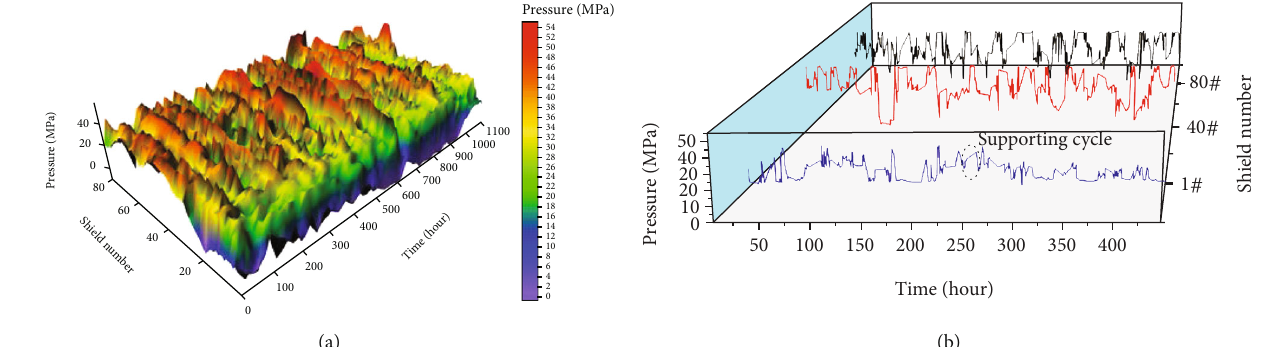
Figure 3: Processed pressure data: (a) pressure data of shields in the 22307 working face; (b) partial processed pressure data of 1#, 40#, and 80#